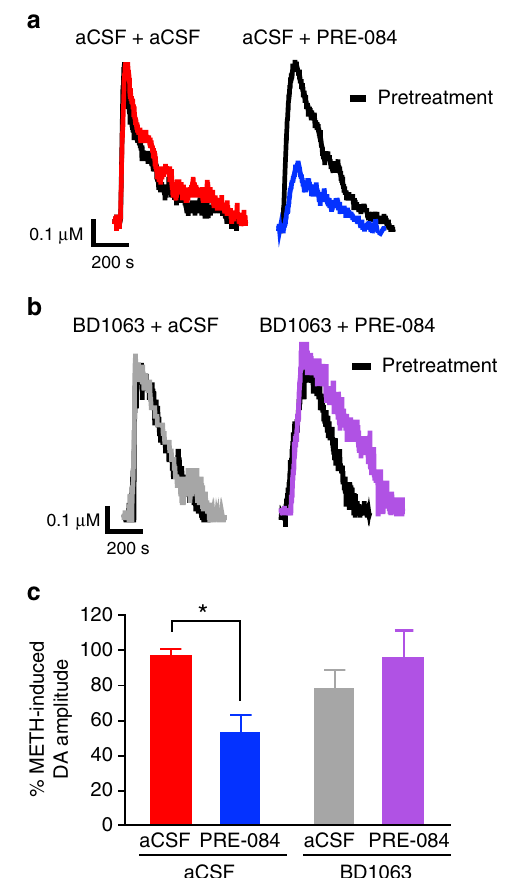
Fig. 4 In vivo σ 1 R activation in the dorsal striatum inhibits METH-induced dopamine ef fl ux. METH was locally applied into the dorsal striatum of anesthetized mice. Representative oxidation currents (converted to a micromolar concentration using a calibration factor determined in vitro) are shown in ( a ) and ( b ). METH signals produced after pretreatment are overlaid with signals obtained after the secondary treatment for ease of comparison. a Representative oxidation traces produced by METH-induced dopamine ef fl ux after pretreatment aCSF treatment (black lines) or subsequent aCSF (red line) or PRE-084 (blue line) treatment. b Representative oxidation currents produced by METH-induced dopamine ef fl ux after BD1063 pretreatment (black lines) or subsequent aCSF (gray line) or PRE-084 (purple line) treatment. c Comparison of the signal amplitude percent change over baseline (pre-aCSF or pre-PRE-084) reveals that intrastriatal application of PRE-084 ( n = 9) but not aCSF ( n = 6) signi fi cantly decreased the amplitude of dopamine release. Application of BD1063 prior to PRE-084 prevented this effect ( n = 4 BD1063 + aCSF, n = 6 for BD1063 + PRE-084, F (1,21) = 6.06, P = 0.0226, Sidak ’ s test for